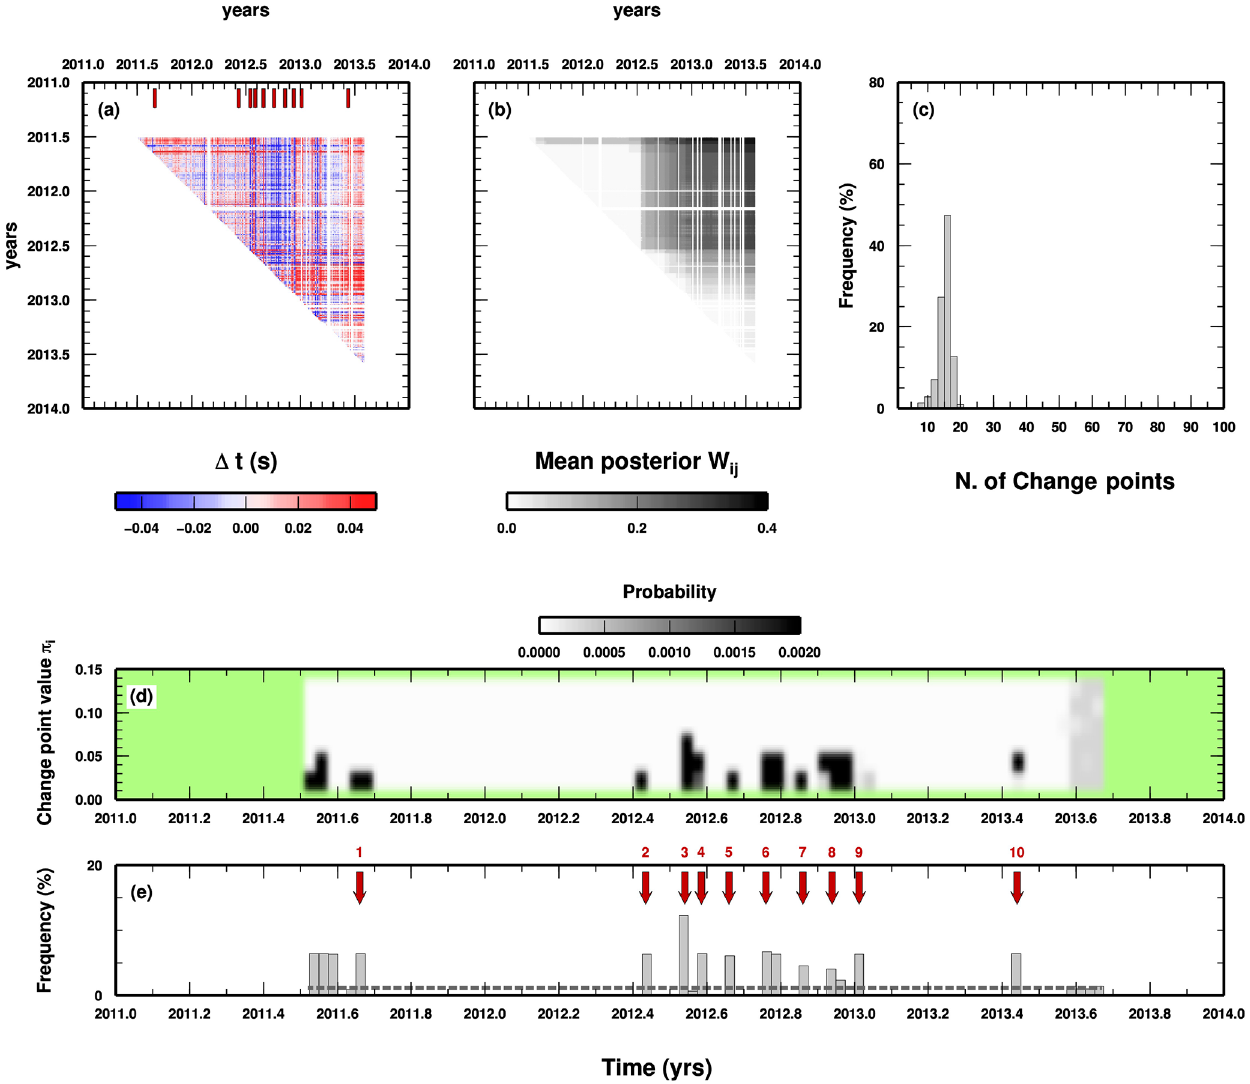
Figure 5. Results of the application of the algorithm to the Katla data set. (a) DD data and position of the most probable changepoints; see panel (e) . Changepoint occurrence in time is indicated by red arrows on top. (b) Mean posterior values for the weights associated with each DD datum. (c) Histogram of the number of changepoints in the sampled models. (d) 1D marginal PPD for the values of the changepoints in time. (e) Histogram of the distribution of changepoints in time. Red arrows and numbers indicate the most probable occurrence in time for a